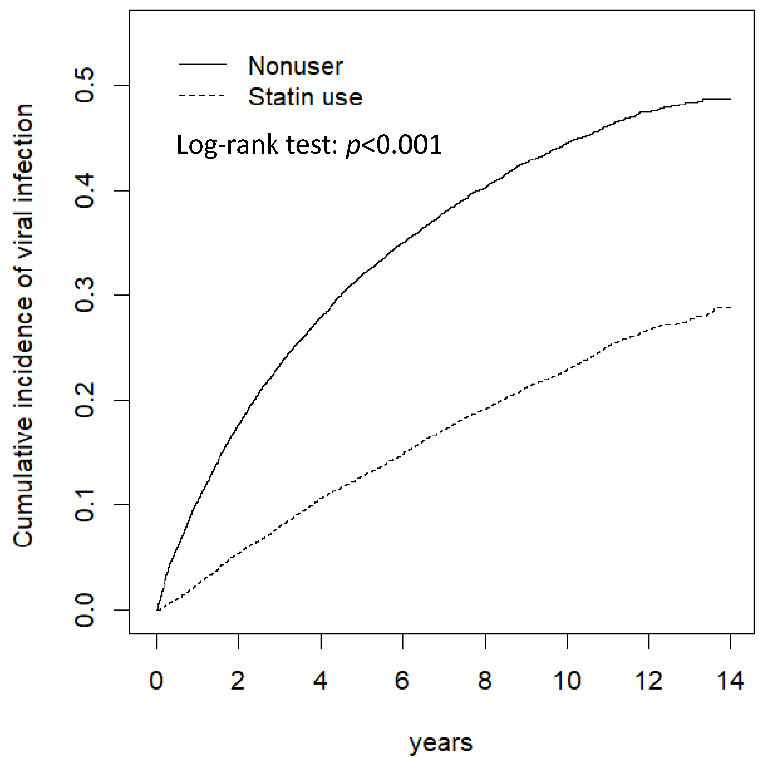
Figure 1. Cumulative incidence of viral infection between statin uses and nonusers.